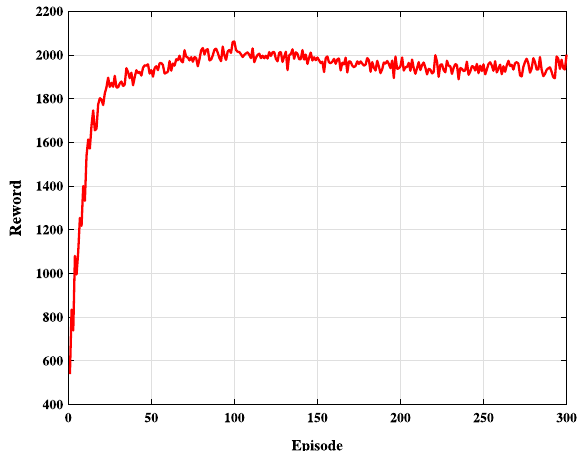
Fig. 3 The total reward of each episode during training of designed policy